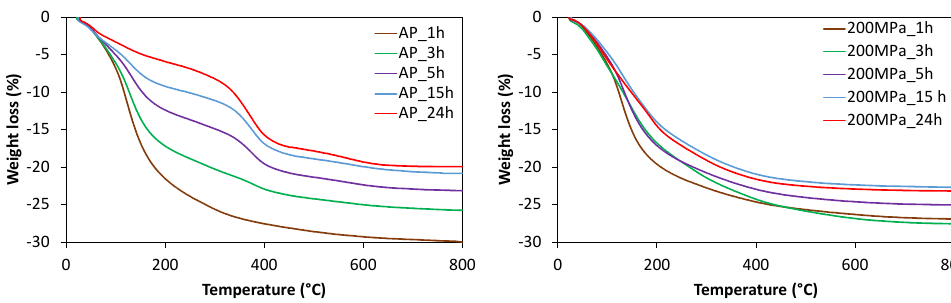
Figure 4. TG profiles of samples obtained under autogenous pressure (AP) and 200 MPa using the diluted synthesis mixtures (H 2 O/Al 2 O 3 = 50).